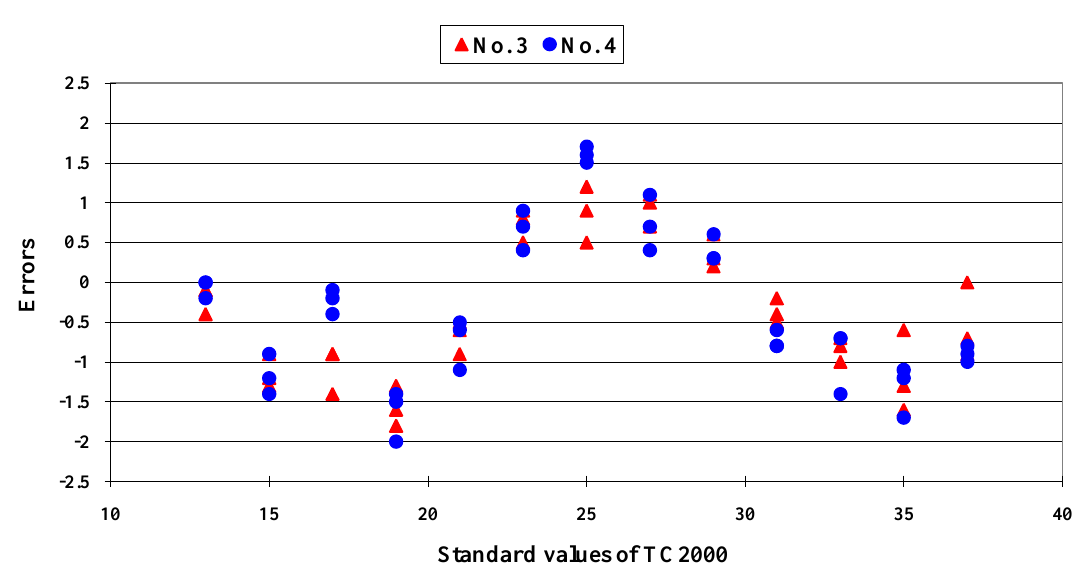
Figure 5. The errors distribution of two Trotec BP-20 infrared thermocouples from the same manufacturer and production